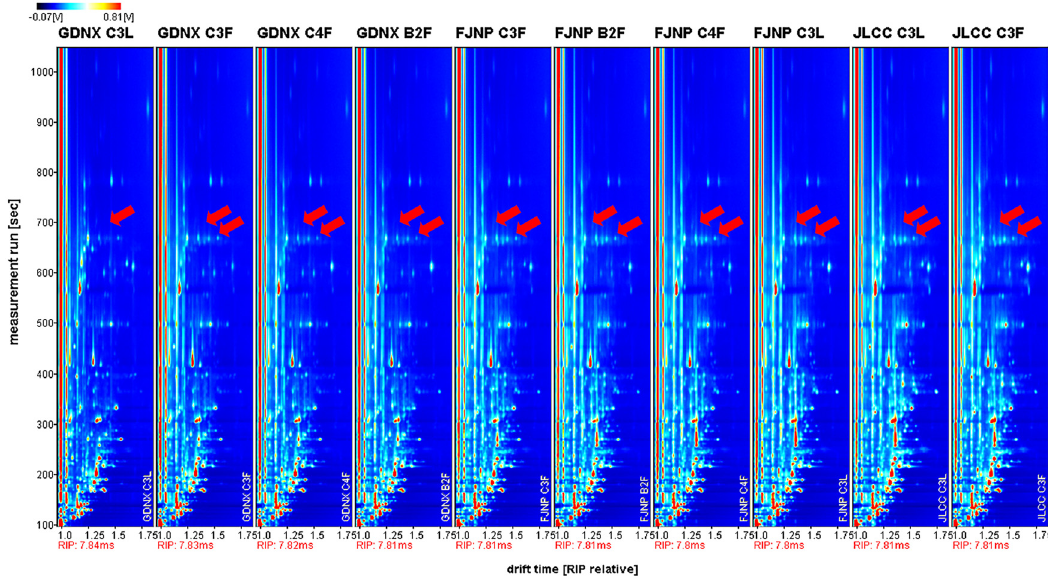
Figure 1: Ion mobility spectrum of tobacco